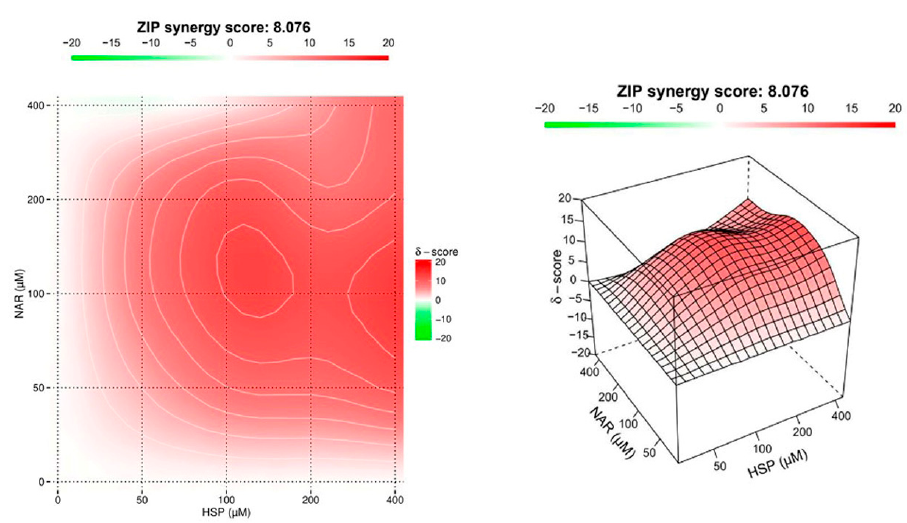
Figure 3. Synergistic effect of the combination between NAR and HSP. The effect of the drug combination on SIRT2 activity was calculated and visualized using SynergyFinder 2.0 software through the ZIP reference model. The synergy score is expressed as the mean of all scores for the dose-response analysis, while the maps shown are representative of three different experimental sessions. The red, white, and green regions of the graphs indicate the synergy, additivity, and antagonism, respectively.